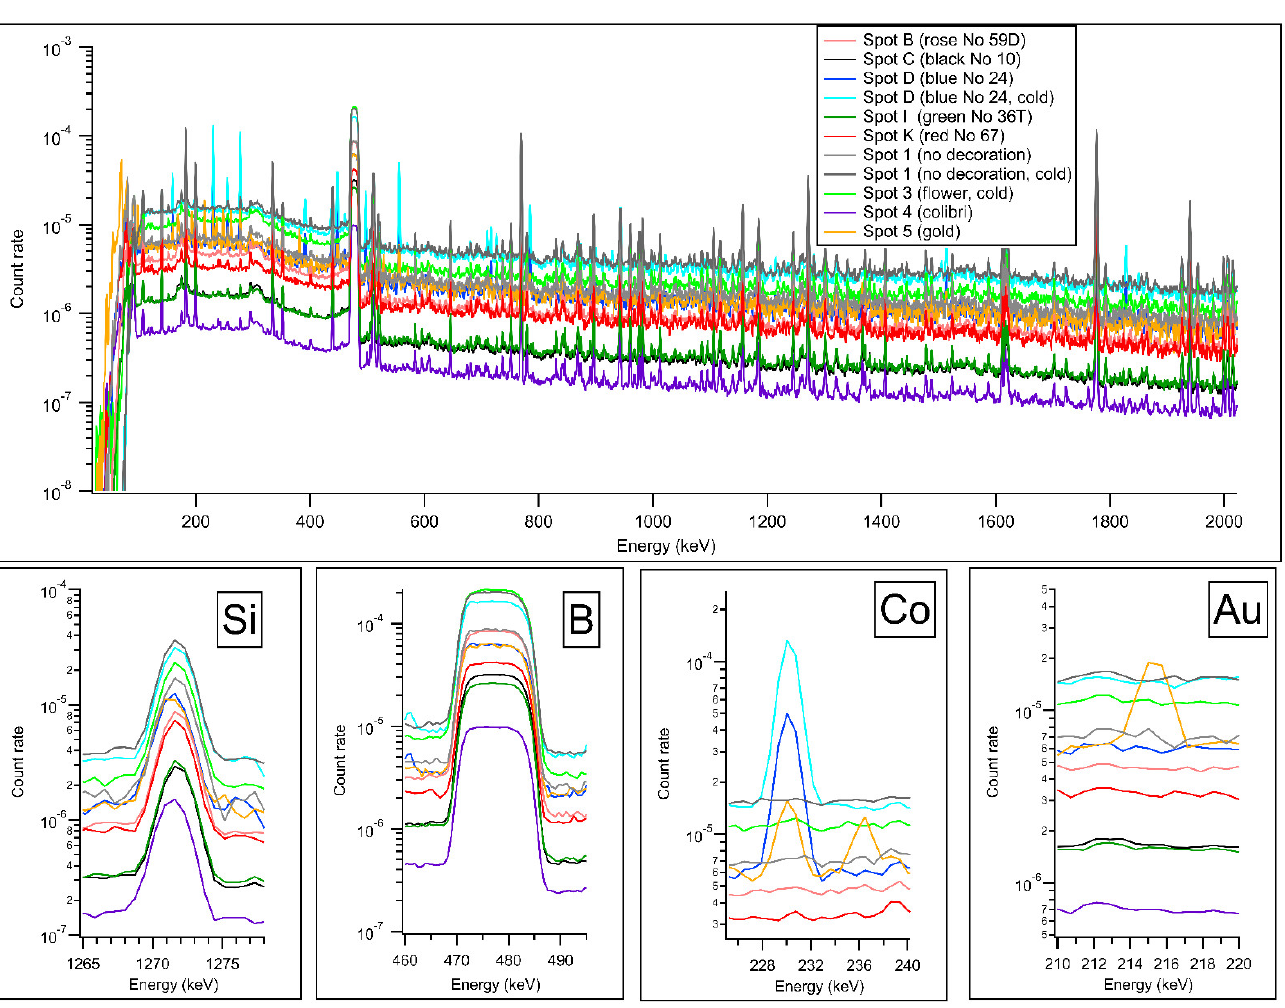
Figure 3. ( a ) PGAA measurement spots (1–5) selected for decoration, ( b ) color palette (A–K), and ( c ) dual-energy X-ray radiogram.